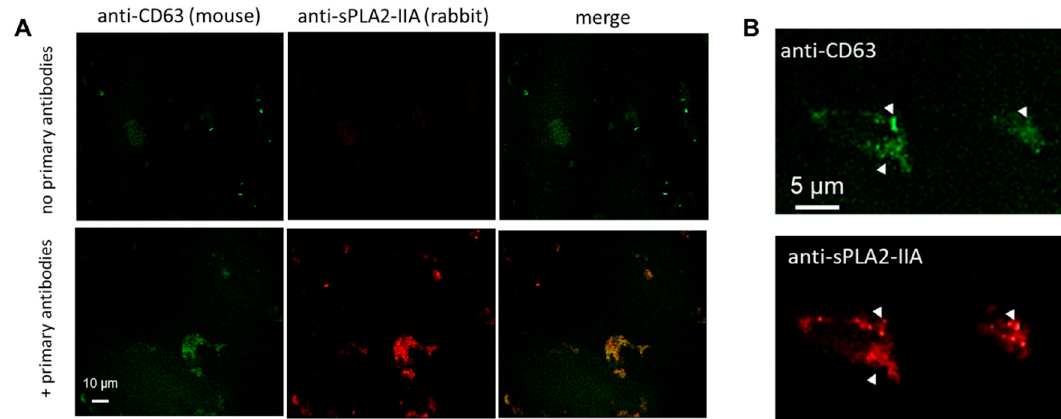
Figure 3. Representative immunofluorescence analysis of crude small EV pellets from one early ARDS patient’s BAL fluid. Vesicles were fixed and stained for the membranous exosomal marker CD63 and sPLA 2 -IIA. ( A ) Control samples in the absence of primary antibodies are shown in the top panel. In the bottom panel, nanovesicle formations presumably aggregates of nanovesicles, were stained positively for both CD63 marker and sPLA 2 -IIA. ( B ) Close examination of stained samples revealed puncta of intense sPLA 2 -IIA staining in CD63 rich aggregates (arrowheads).